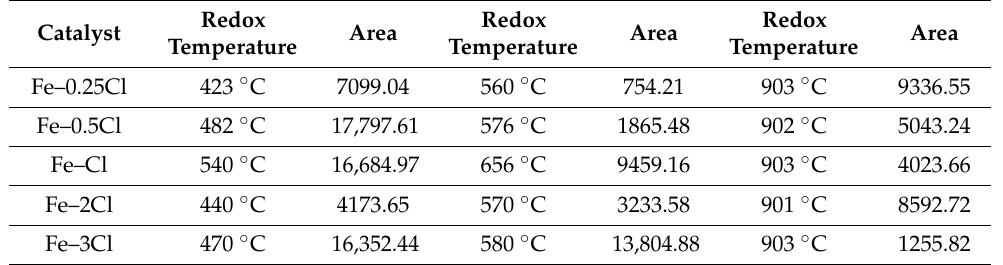
Table 2. Catalyst reduction temperatures and areas.